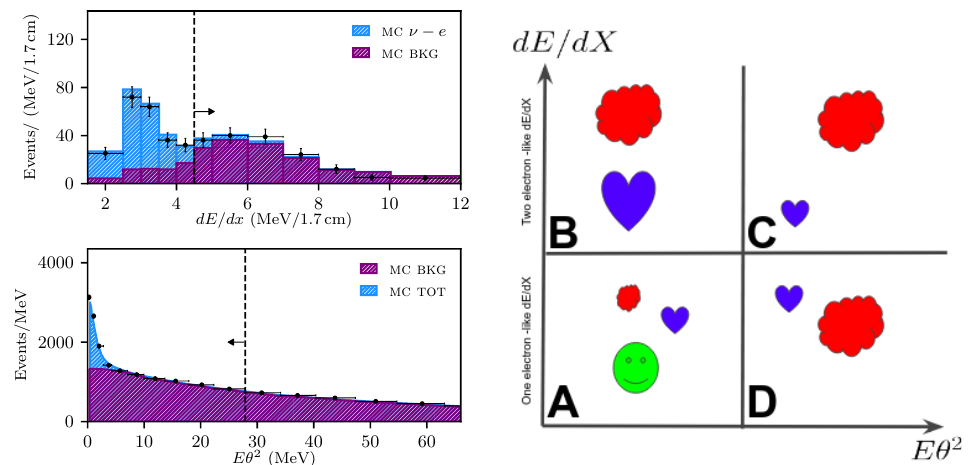
Figure 9.3: Data plots used in the analysis and a cartoon that explains how they are related. Left top: Distribution of Minerva low-energy mode neutrino-electron cross section event selection without the dE / d x cut. We use the rate of events to the right of the cut, as signalled by the arrow, to place perform our analysis. Left bottom: Distribution of CHARM-II neutrino-electron cross section analysis without the E θ 2 cut. The rate to the left of the cut, as pointed by the arrow, is used in our analysis. Right: The content of the different parts of phase space in the two variables used in our analysis, dE / d x and E θ 2 . The Minerva distribution used in our analysis corresponds to panels A and B, while the CHARM-ii information used corresponds to panels A and D. The markers signal electron-neutrino (green happy face), di-electrons produced in the dark neutrino model (purple heart), and back- grounds such as neutral-current π (red clouds). The sizes of the markers are meant 0 to illustrate their relative contributions, though exact sizes are experiment and dark neutrino parameter-point dependent; the location of the makers within each of the panels (A,B,C, and D) does not have